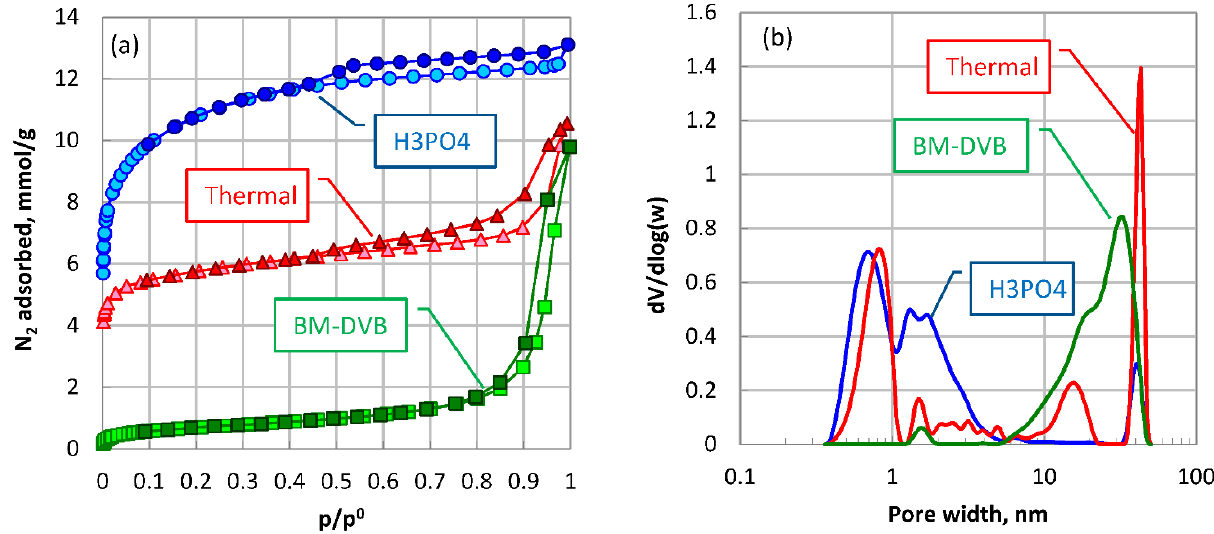
Figure 2. Nitrogen adsorption-desorption isotherms: ( a ) and pore size distributions; and ( b ) for parent BM-DVB copolymer and carbons obtained by carbonization at 600 °C of polyimide copolymer in the presence of phosphoric acid (H 3 PO 4 ) and without acid (Thermal).